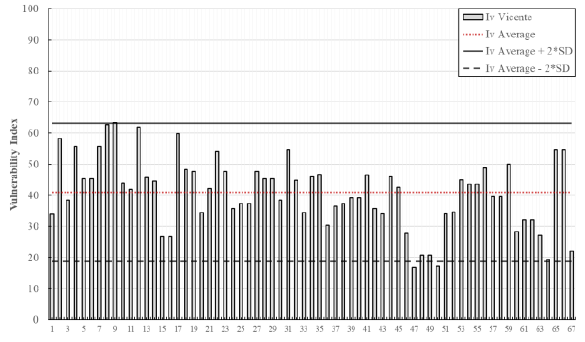
Figure 11. Application of Vicente method, representation of results.